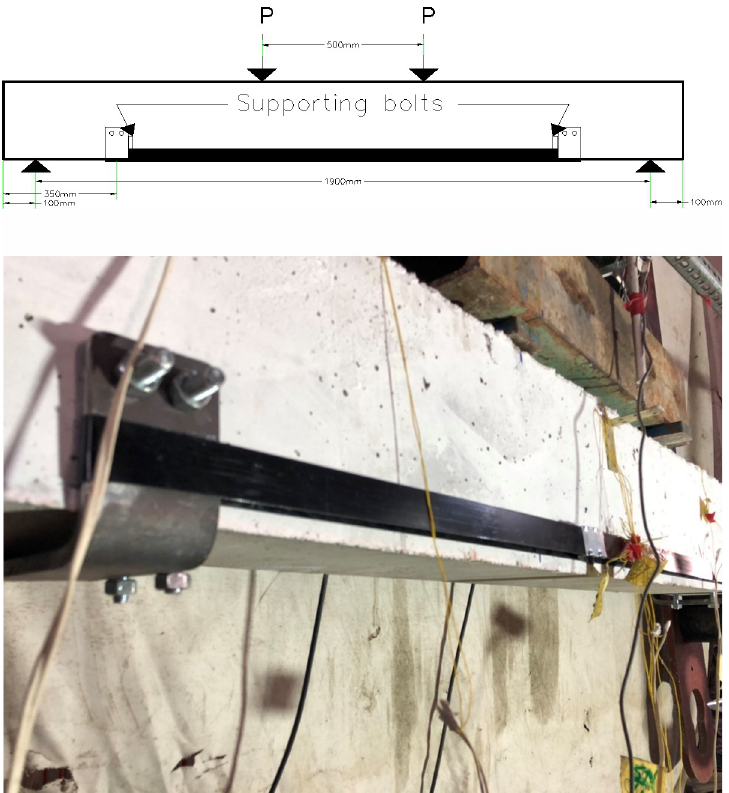
https://doi.org/10.1371/journal.pone.0253816.g012